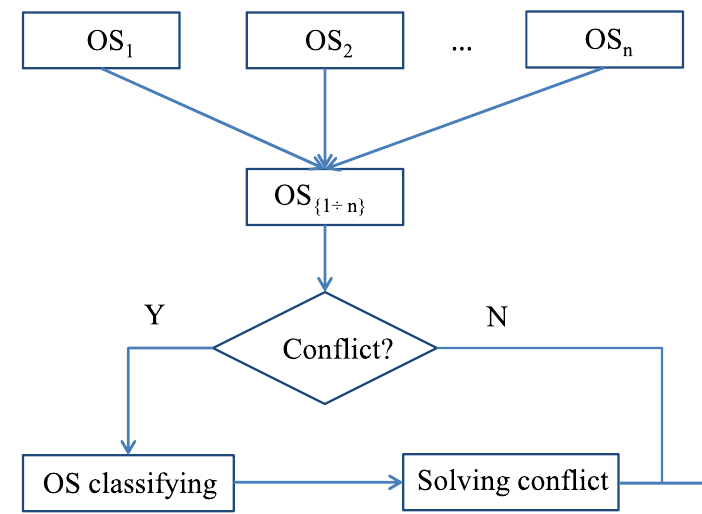
Fig. 7 Schematic of classifying and solving conflict between multiple